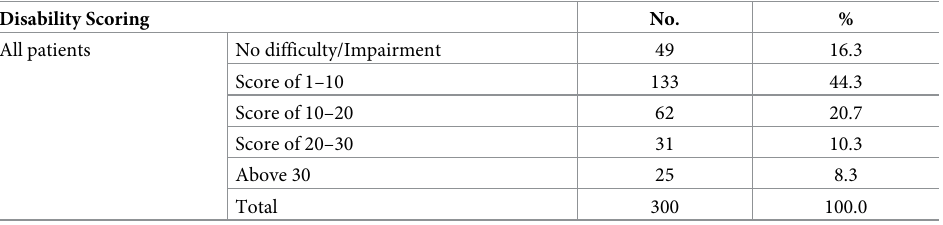
Table 2. Overall assessment of mycetoma disability using cumulative disability scoring.